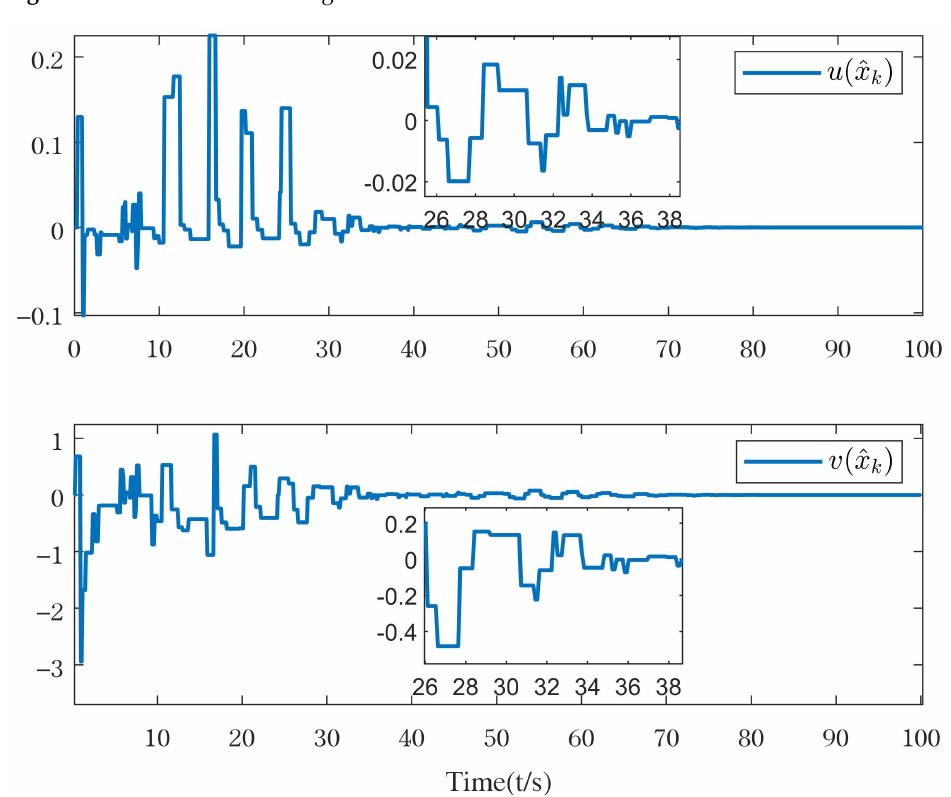
Figure 9. The control law u ( ˆ x k ) and the perturbation law υ ( ˆ x k )